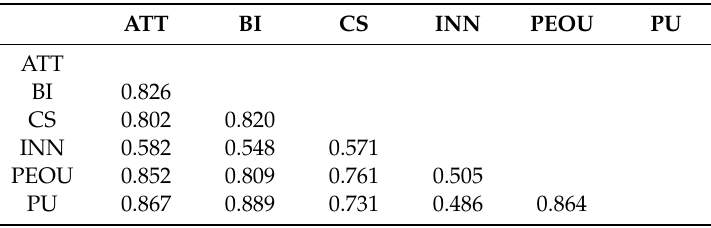
Table 9. Heterotrait-Monotrait